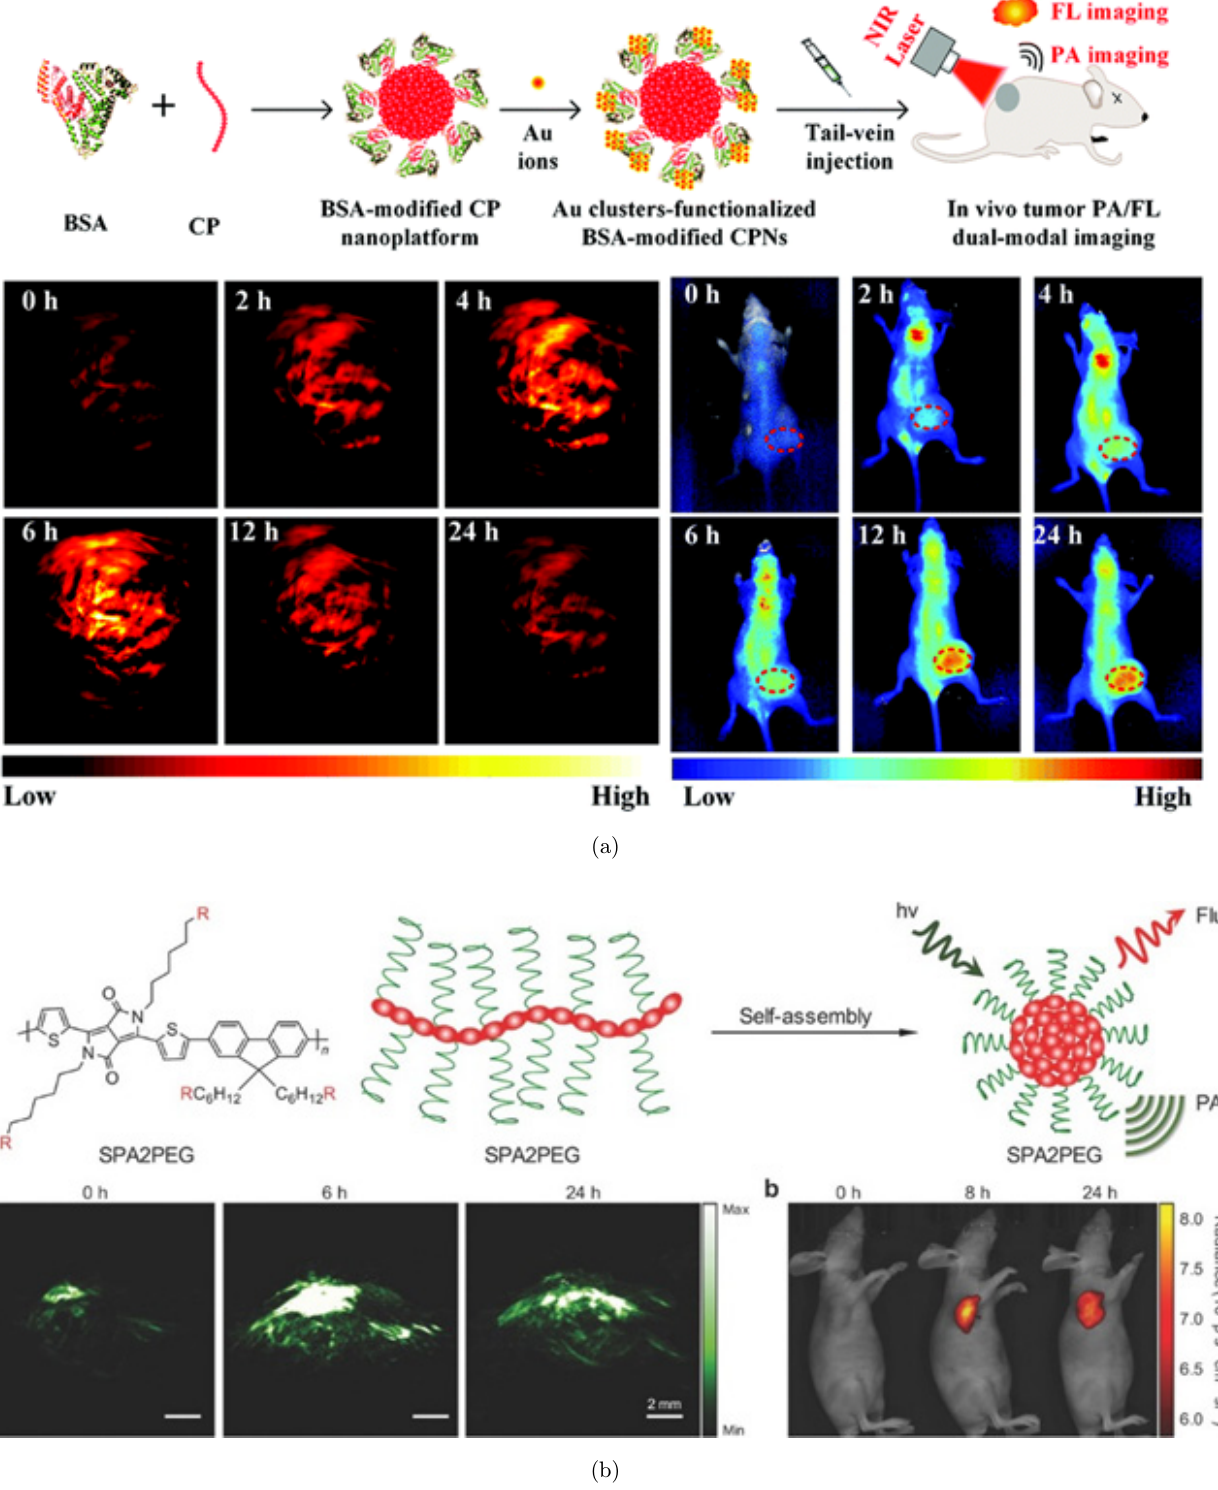
Fig. 4. (a) Au clusters-functionalized BSA-modi¯ed CPNs for FLI and PAI of tumor in vivo . a (b) Real-time PAI and FLI of tumors after systemic administration of SPA2-PEG2 in tumor bearing mice.